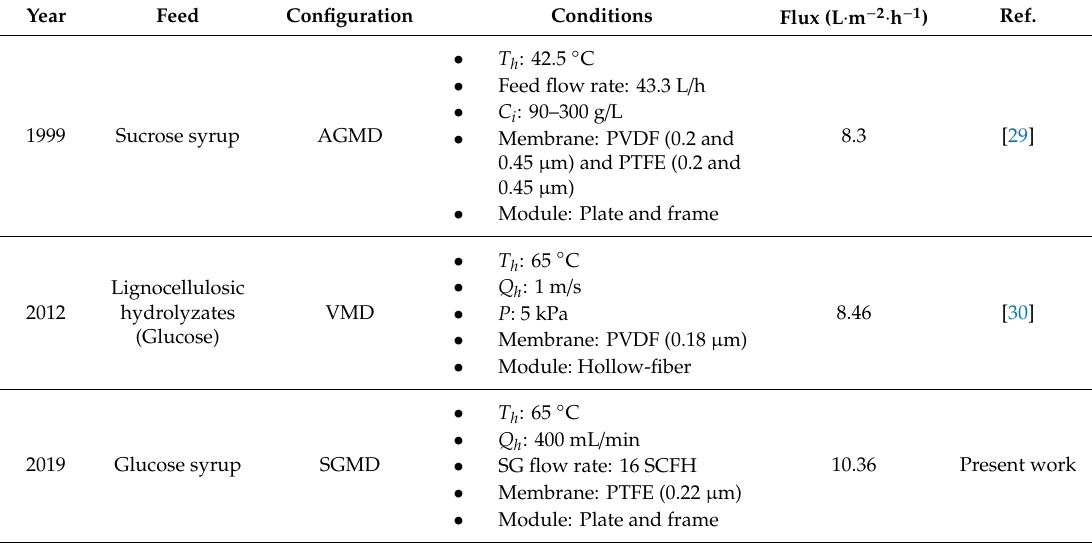
Table 7. Experimental results of this work and literature data for concentrating of sugar syrup using the MD